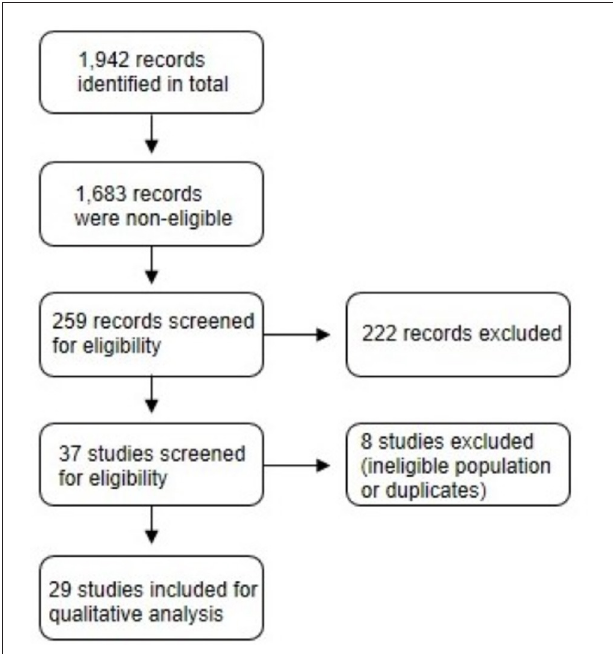
FIGURE 1 | A flow diagram of the screening process for selecting eligible studies.